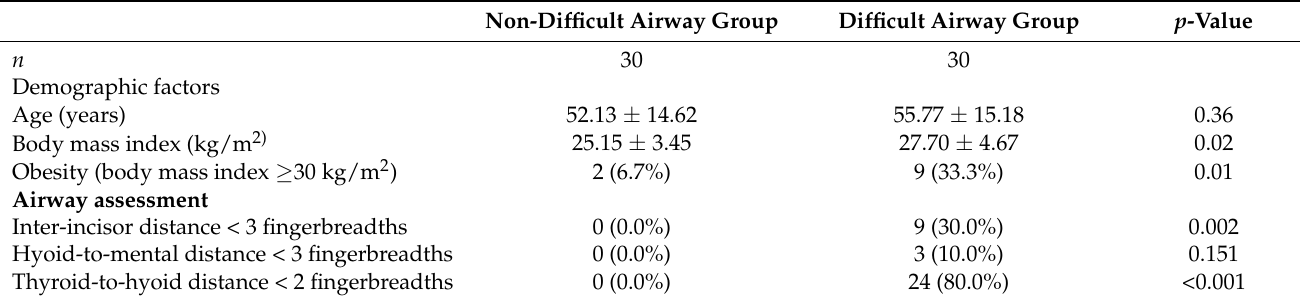
Table 1. Demographic data and airway